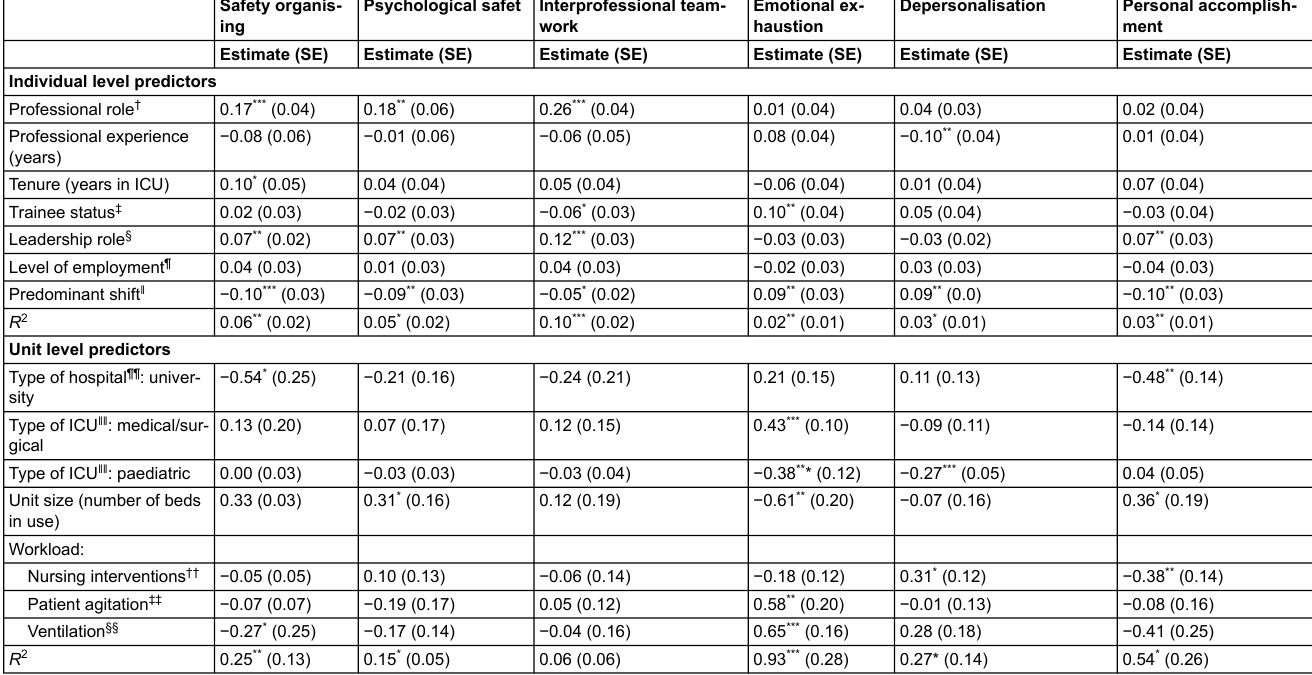
Table 4: Results of multilevel regression analyses of teamwork (safety organising, psychological safety, interprofessional teamwork) and burnout (emotional exhaustion, deper- sonalisation, personal accomplishment) on demographic and unit characteristics. Safety organis-